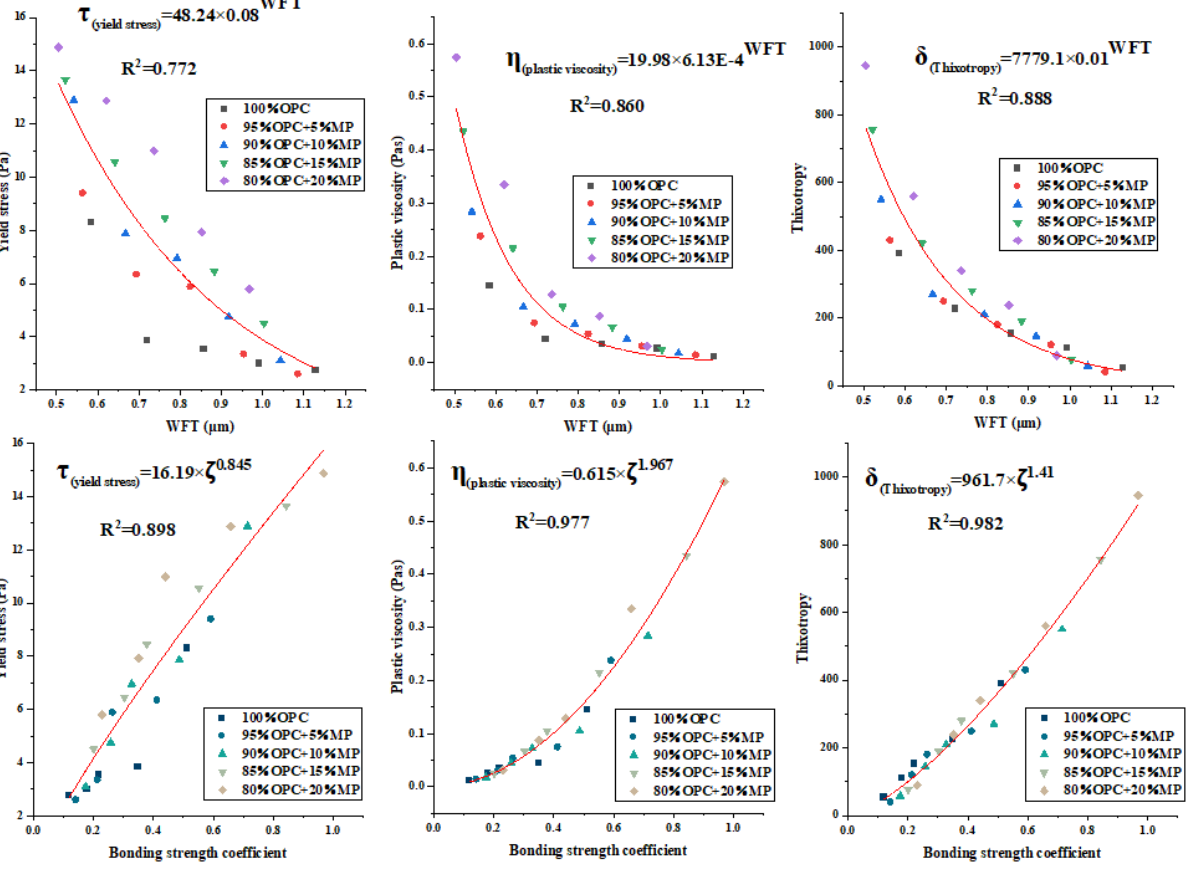
Figure 14. Yield stress, plastic viscosity and thixotropy versus WFT and bonding strength coeffi- cient.